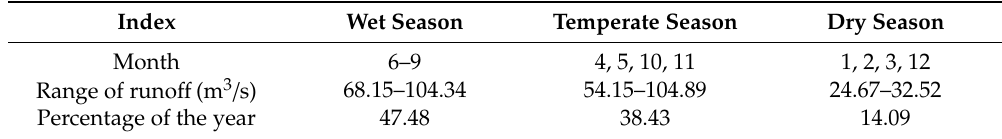
Table 2. Data types, sources and